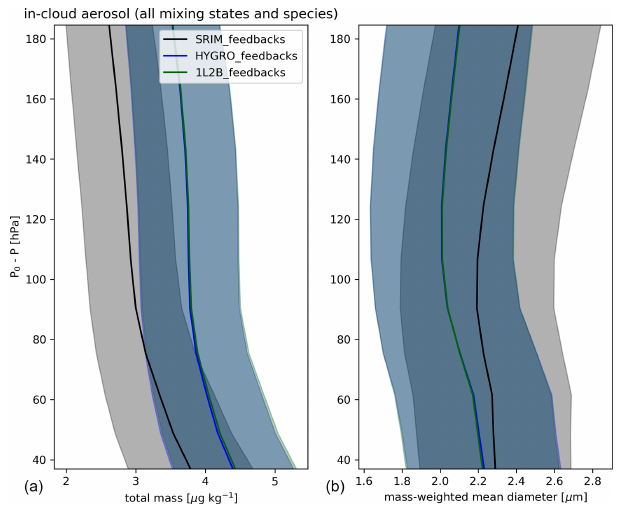
Figure 9. Vertical distribution of temporally and horizontally aver- aged aerosol properties in cloudy grid cells in the SRIM_feedback, HYGRO_feedback, and 1L2B_feedback simulations. (a) Total mass mixing ratios. (b) Mass-mean aerosol diameter. The shading indicates 1 temporal standard deviation about the